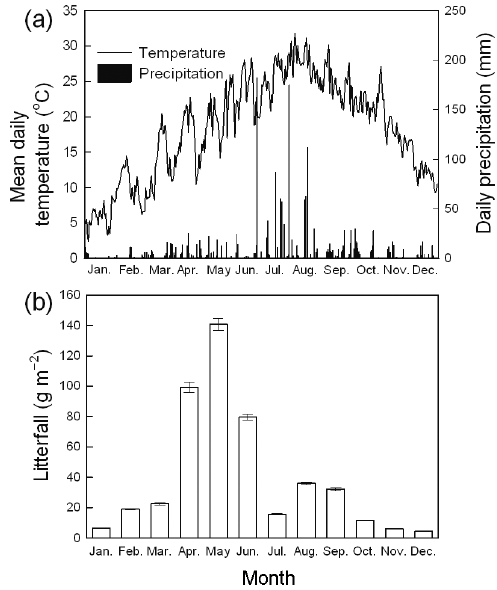
Figure 1. Seasonal variations of air temperature, precipitation and litterfall in a Bambusapervariabilis 6 Dendrocalamopsisdaii plantation from January to December 2009. (a) Mean daily temperature and daily precipitation; (b) monthly litterfall. Bars indicate